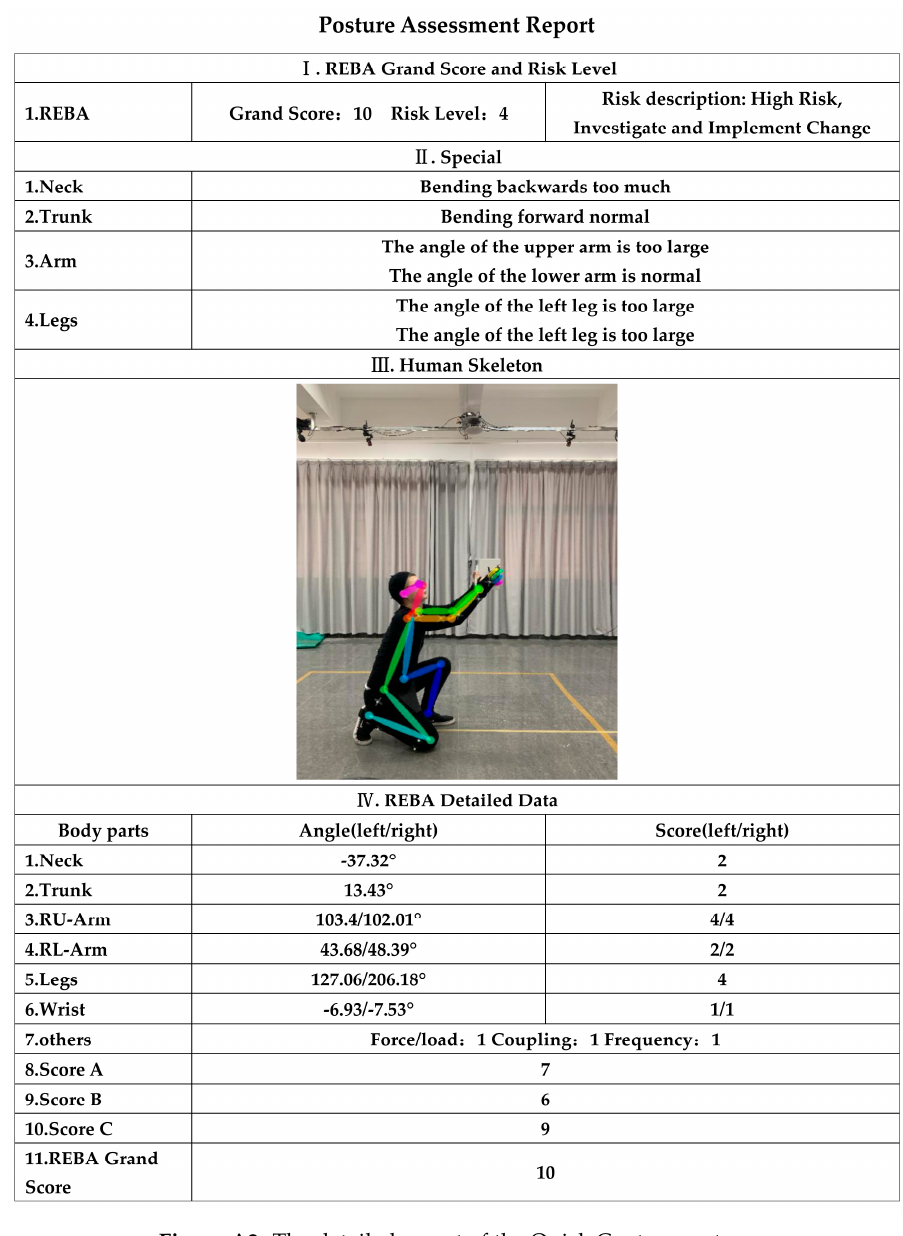
Figure A2. The detailed report of the Quick Capture system.